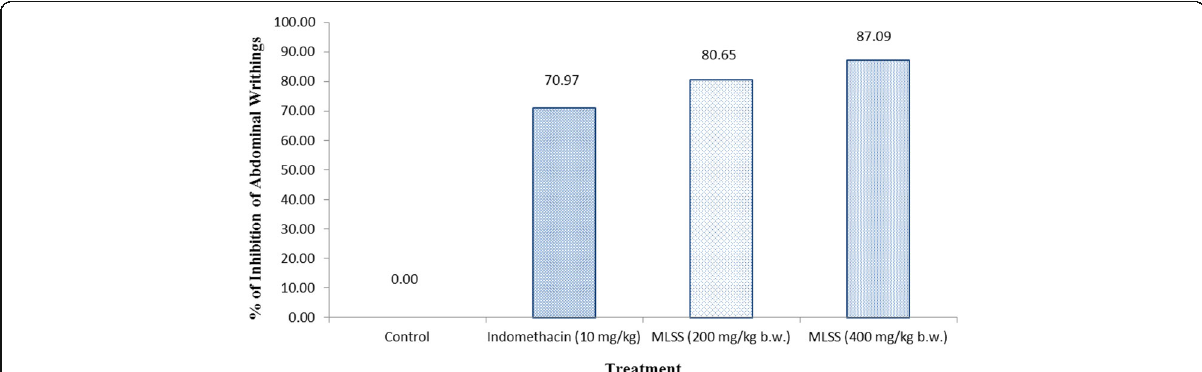
Fig. 2 Percentage of inhibition of abdominal contractions in acetic acid induced writhing method by L. sativus L. seeds and standard indomethacin. MLSS=Methanolic extract of L. sativus L.